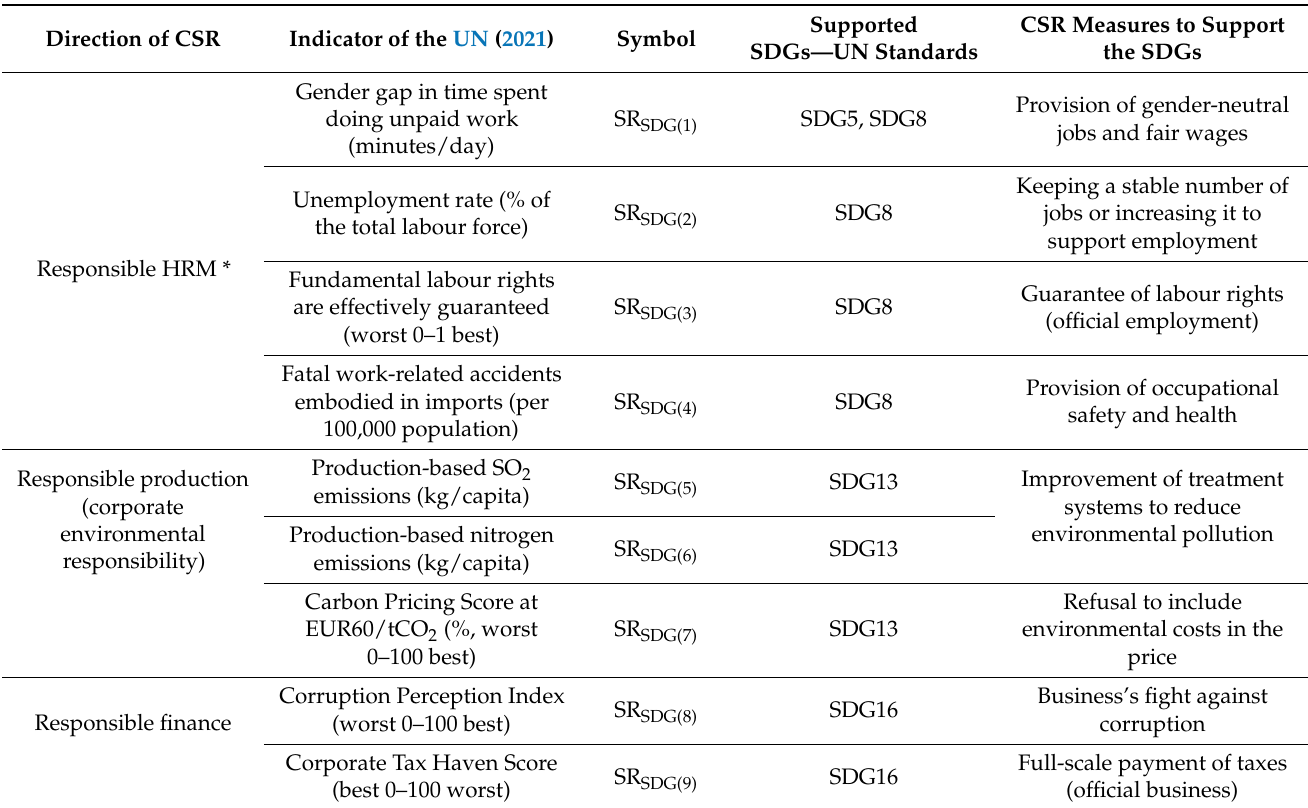
Table 2. Detailed characteristics of the integration of the SDGs into corporate strategies during the alternative